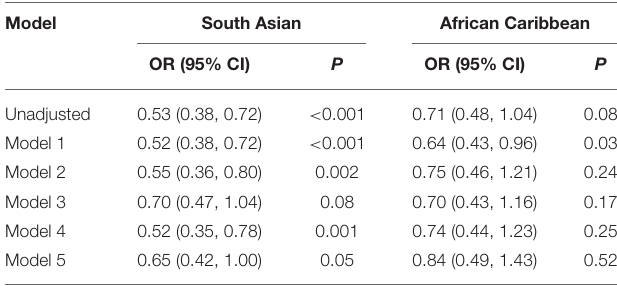
TABLE 2 | Blood pressure control in South Asian and African Caribbean people compared with Europeans with and without adjustment. Model South Asian African